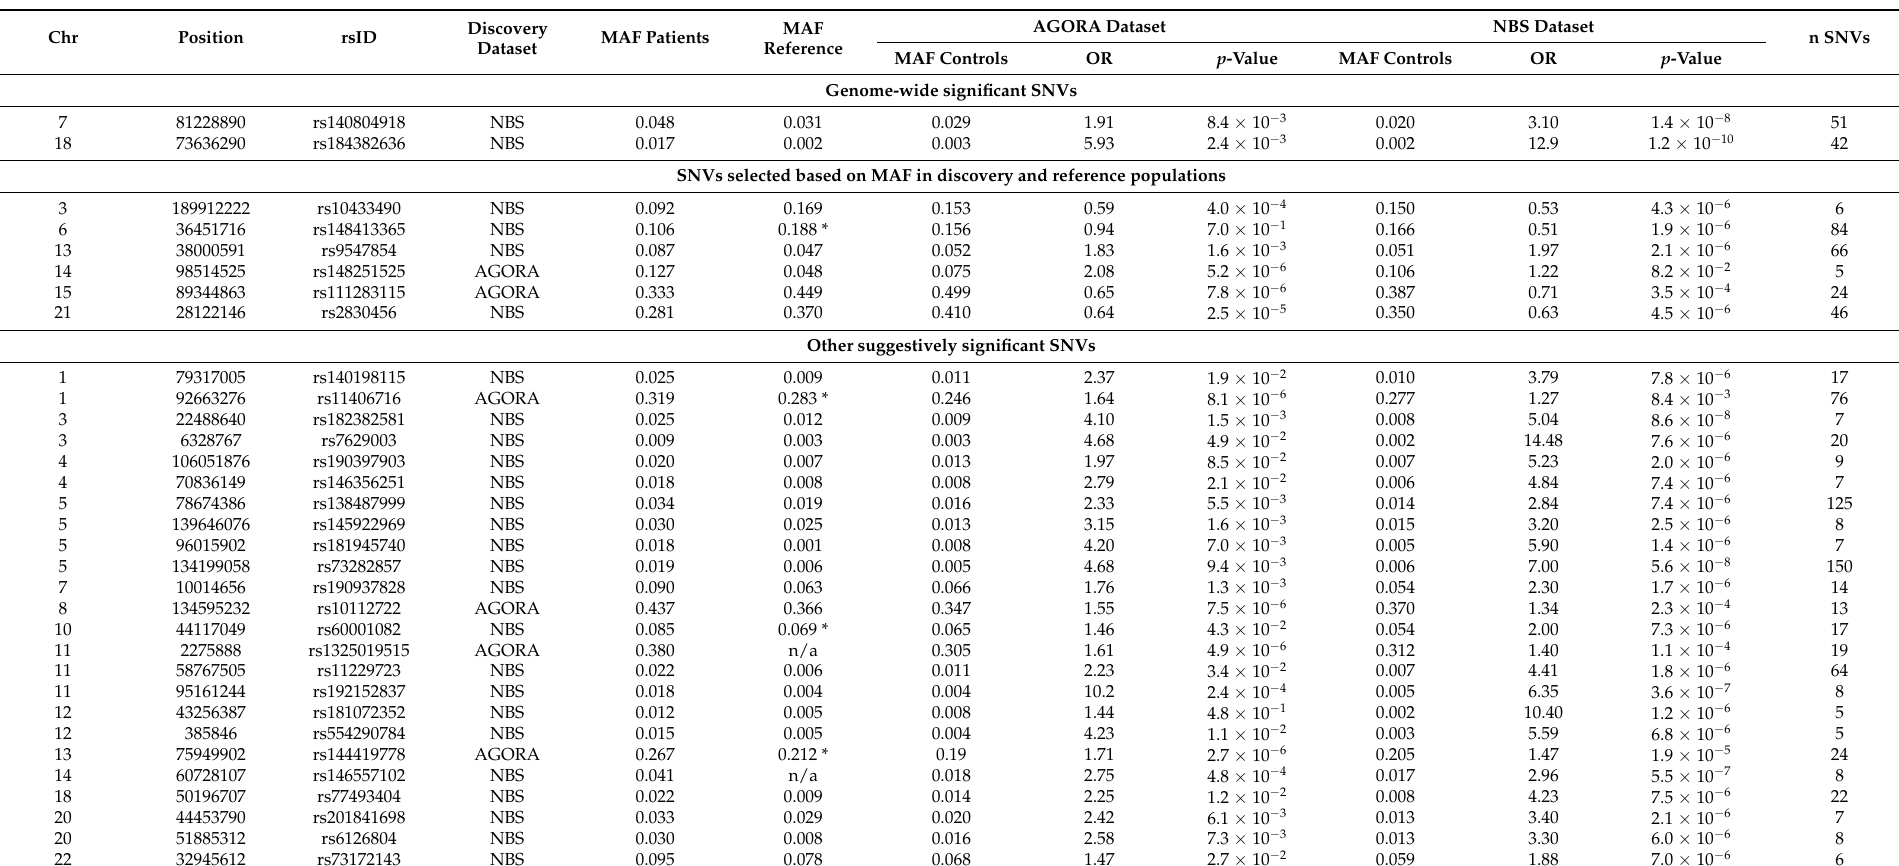
Table 1. Genomic risk loci with at least five SNVs with a p -value below 1 × 10 − 5 identified in a genome-wide association study of congenital solitary functioning kidney, with the lead SNV for each locus being